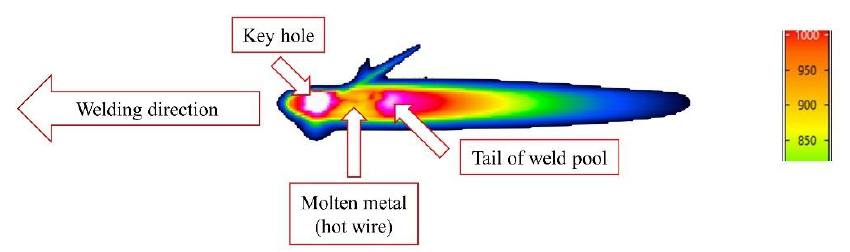
Figure 11. The temperature profile of run order 4. Figure 12. The characteristics of the weld pool results in an M-shaped graph. Figure 12. The characteristics of the weld pool results in an M-shaped Figure 12. The characteristics of the weld pool results in an M-shaped graph.